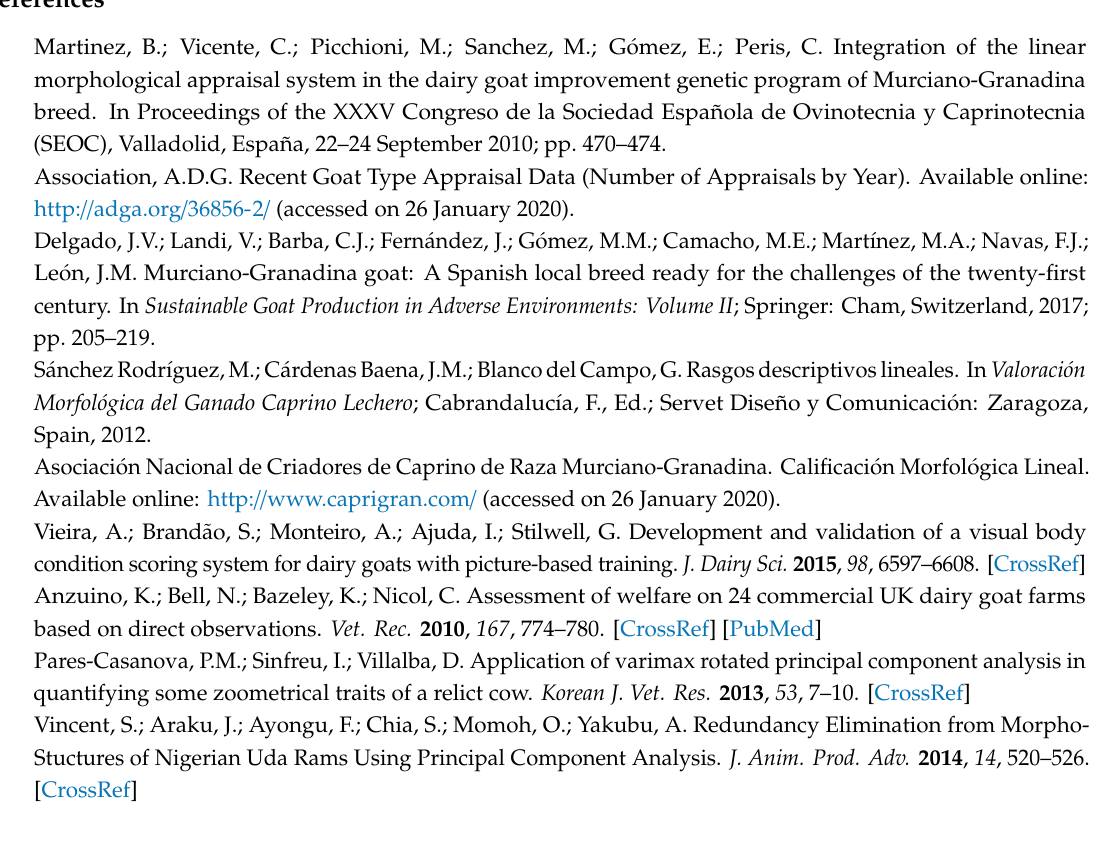
the scale for rump angle in Murciano-Granadina bucks for dairy purpose-related zoometric assessment. Figure S23: Graphical depictions of the scale for angulosity in Murciano-Granadina bucks for dairy purpose-related zoometric assessment; Figure S24: Graphical depictions of the scale for bone quality in Murciano-Granadina bucks for dairy purpose-related zoometric assessment; Figure S25: Graphical depictions of the scale for rear legs, rear view in Murciano-Granadina bucks for dairy purpose-related zoometric assessment; Figure S26: Graphical depictions of the scale for rear legs, side view in Murciano-Granadina bucks for dairy purpose-related zoometric assessment; Figure S27: Graphical depictions of the scale for mobility in Murciano-Granadina bucks for dairy purpose-related zoometric assessment; Table S1. Detailed and analytical composition of the diet provided to the animals; Table S2. Summary of descriptive statistics for zoometric traits in Murciano-Granadina primipara does derived from linear appraisal and zoometric assessment; Table S3. Summary of descriptive statistics for zoometric traits in Murciano-Granadina multipara does derived from linear appraisal and zoometric assessment; Table S4. Summary of descriptive statistics for zoometric traits in Murciano-Granadina bucks derived from linear appraisal and zoometric assessment; Table S5. Spearman’s correlation coe ffi cients for linear appraisal-derived zoometric traits in Murciano-Granadina primipara does; Table S6. Spearman’s correlation coe ffi cients for linear appraisal-derived zoometric traits in Murciano-Granadina multipara does; Table S7. Spearman’s correlation coe ffi cients for linear appraisal-derived zoometric traits in Murciano-Granadina bucks; Table S8. Simplification process of categorical linear regression (CATREG) models for does and bucks from the general description to a reduced dimensionality after principal components analysis (PCA) and development of linear comparative models to determine the validity of linear appraisal traits as opposed to Murciano-Granadina zoometric traditional